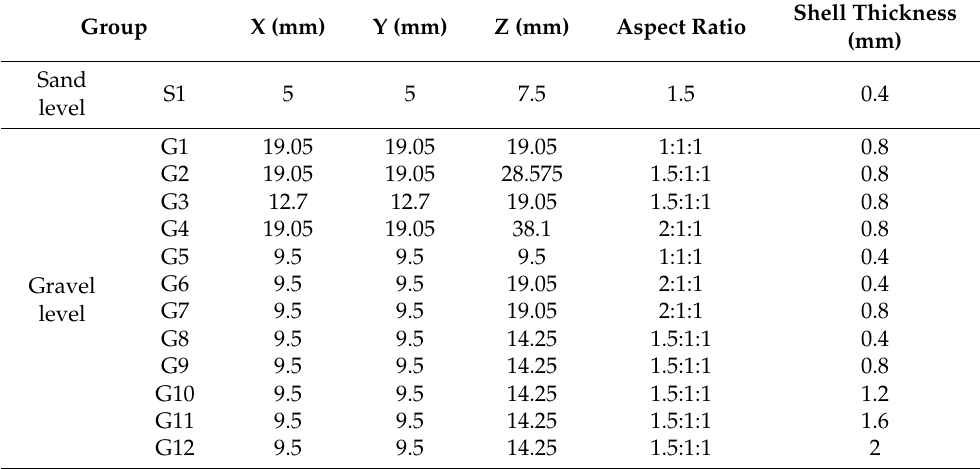
Table 2. Summary of the capsule’s dimension and geometry for survivability